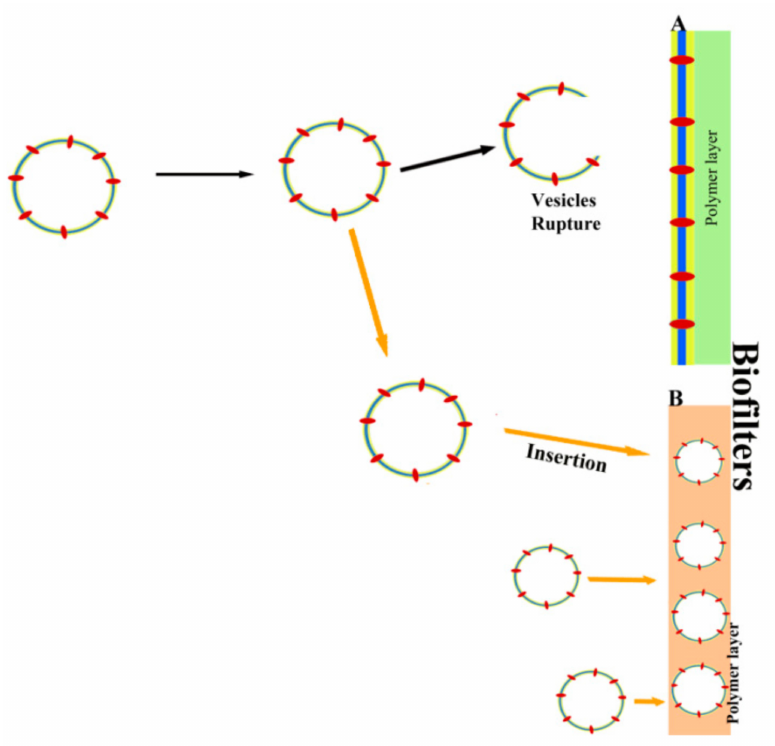
Figure 3. Schematic presentation of AQPs biofilter production. ( A ) AQPs lipid layer is made from vesicle rupture onto substrate layer by interaction between lipid and polymers. ( B ) Proteolipids vesicles are incorporated inside the polymers layer to make